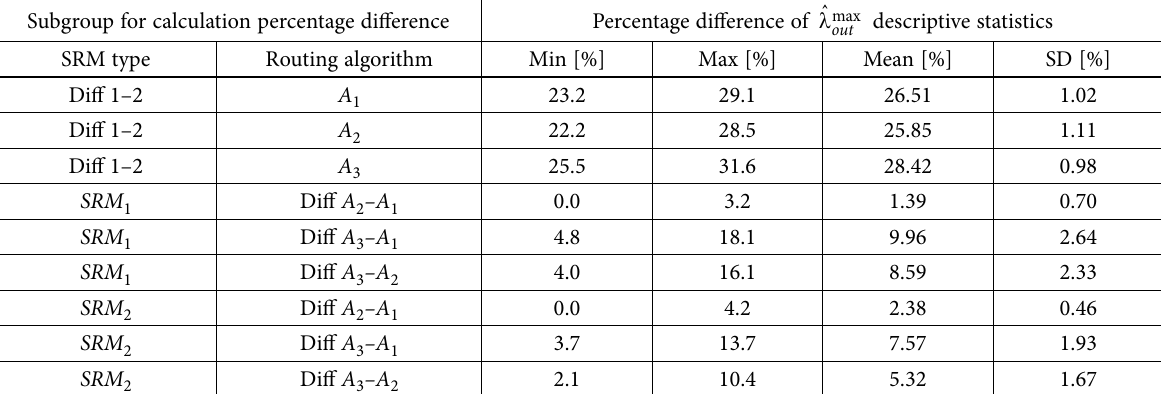
Table 2. Comparison of percentage differences of λ max ˆ out between systems with different SRM types and routing algorithms Subgroup for calculation percentage